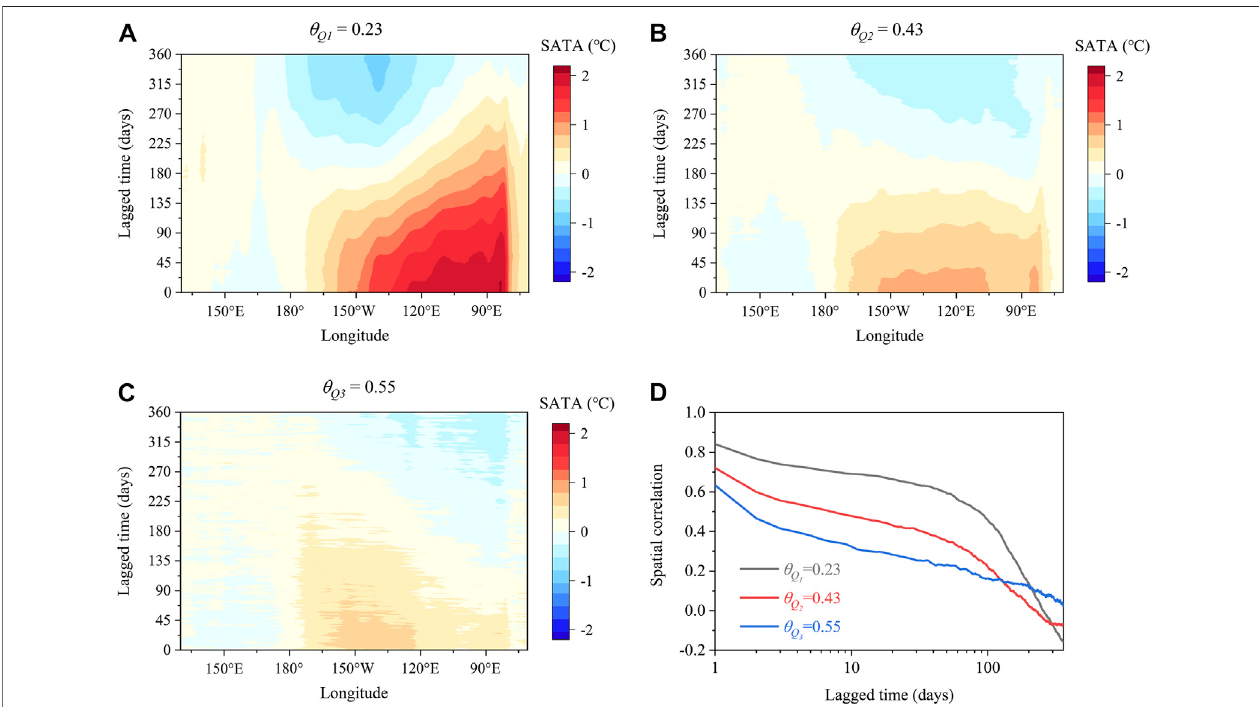
FIGURE 5 | Comparison of the SATA Hovmöller diagrams between high and low persistence (during El Niño episodes). (A) SATA is averaged over 5 ° S – 5 ° N as a function of the lag time and longitude, with compositing the days with the θ Q 1 group (average of θ SATA : θ Q 1 = 0.23). (B) Same as (A) , but for the θ Q 2 group (average of θ θ θ θ θ SATA : Q 2 =0.43). (C) Sameas (A) ,butforthe Q 3 group(averageof SATA : Q 3 =0.55). (D) SpatialcorrelationbetweentheSATA ones. The black line represents the average result for the θ Q 1 group, red for the θ Q 2 group, and blue for the θ Q 3